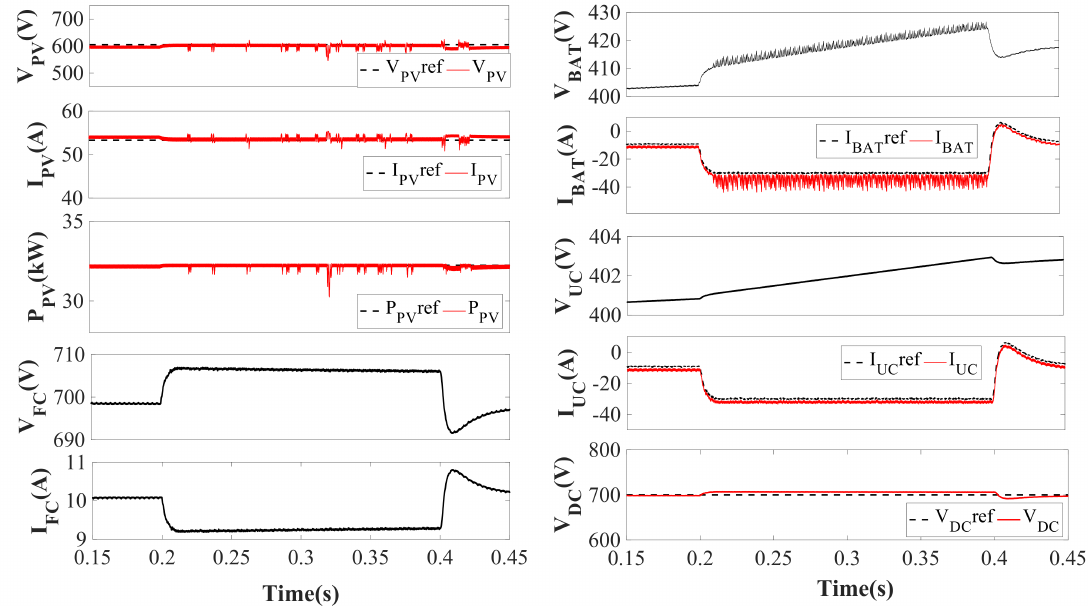
Figure 16. Dynamic performance during islanding and re-synchronization of V PV , I PV , P PV ,V FC , I FC ,V Bat , I Bat , V UC , I UC , and V DC